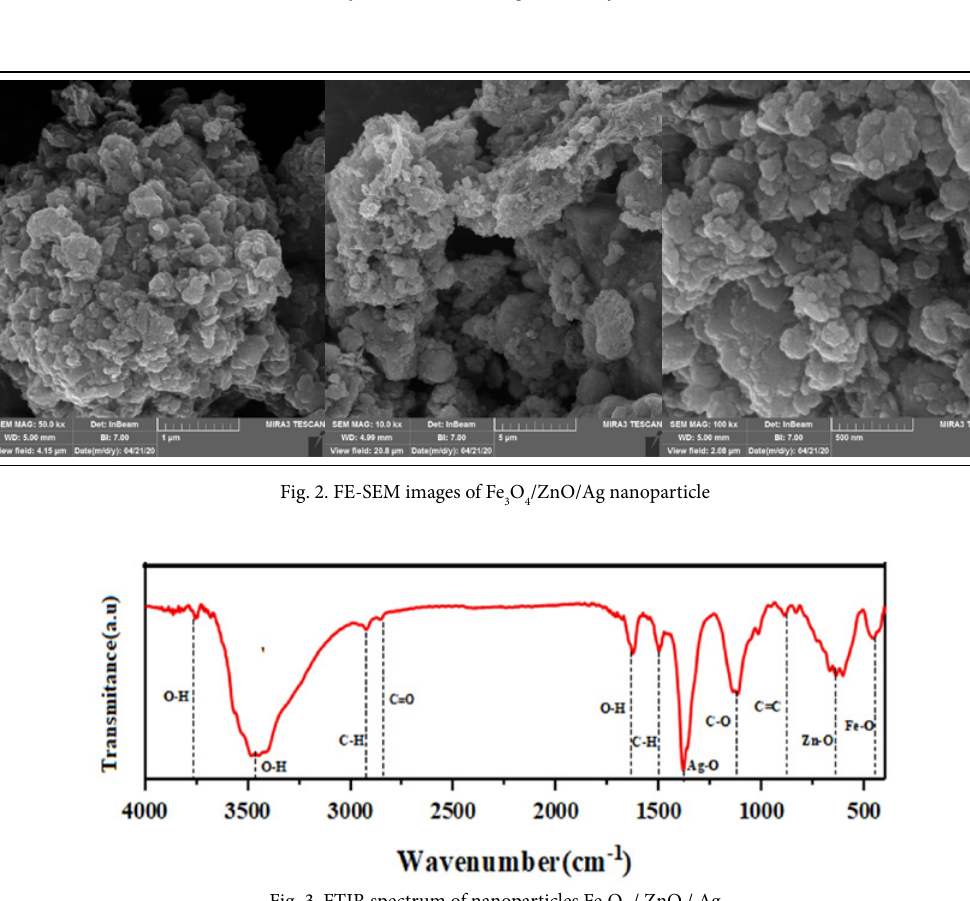
Fig . 3. FTIR spectrum of nanoparticles Fe